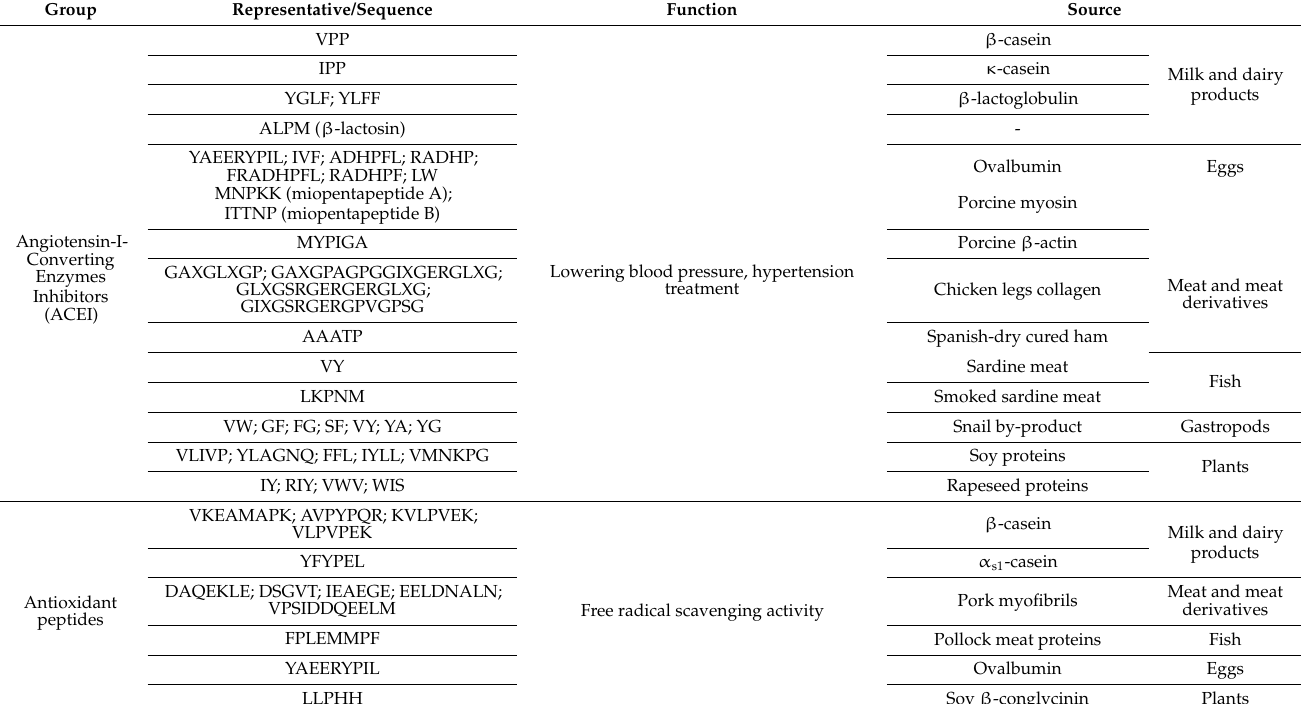
Table 7. Bioactive peptides—examples of groups, functions and sources